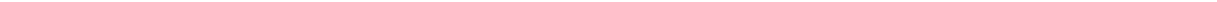
Fig. 8 Otx2 and Lmx1a/b control Plxnc1 expression in the VTA. a , b Confocal images of Otx2 immunostaining in TH-positive cells in coronal midbrain sections of control and Lmx1a/b cKO mutant mice showing ectopic Otx2 expression in SNpc mDA neurons. c Quanti fi cation of the number of mDA neurons in SNpc with ectopic expression of Otx2 ( n = 3, two-tailed unpaired t test, p = 0.0015). d Rt-qPCR quanti fi cation of Otx2 in VTA and SNpc isolated from control and Lmx1a/b cKO with LCM (VTA: n = 3 for control and n = 5 for Lmx1a/b cKO, two-tailed unpaired t test, p = 0.9128; in SNpc n = 3, one- tailed Mann – Whitney U , p = 0.05). e Overexpression of Otx2 in primary cell cultures leads to an increase of Plxnc1 expression as quanti fi ed by RT-qPCR ( n = 3 independent cultures; for Plxnc1: two-tailed unpaired t test, p = 0.03; for Otx2: Mann – Whitney U , p = 0.0286). f RT-qPCR quanti fi cation of Otx2 in mDA primary cell cultures following Lmx1a and Lmx1b overexpression ( n = 8 for control, n = 7 for Lmx1a and n = 5 for Lmx1b; one-way ANOVA with Tukey ’ s multiple comparison test, not signi fi cant). g Representative images of TH and Otx2 immunolabeling from E15.5 Lmx1a/b cKO embryo at E15.5 showing SNpc neurons co-expressing Otx2 and TH (arrows) before and after LCM. Right panels are high magni fi cation of the left panels. h RT-qPCR quanti fi cation of Plxnc1 expression from LCM isolated cells co-expressing Otx2 and TH in VTA and SNpc from control and Lmx1a/b cKO embryos. For control SNpc, TH-positive cells were isolated ( n = 3, 5 – 8 cells per embryo, one-way ANOVA with Tukey ’ s multiple comparison test, not signi fi cant between groups expressing Plxnc1). Image on the right is a representative image of the gel showing the RT-qPCR product. Plxnc1 was not detected in mDA neurons of SNpc from control. Scale bars: a , 200 µ m; b , 10 µ m; g (left), 100 µ m, (right), 10 µ